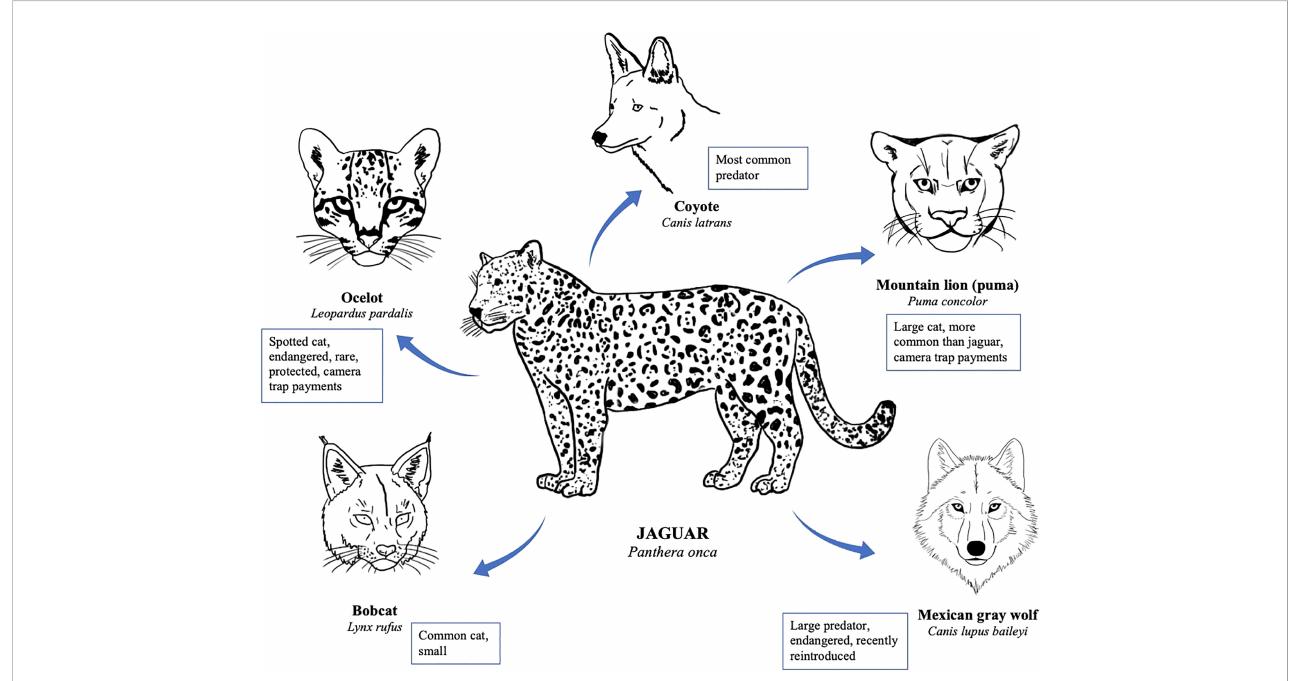
FIGURE 4 How do we relate to a rare, elusive predator? The jaguar ’ s place on the landscape among other native